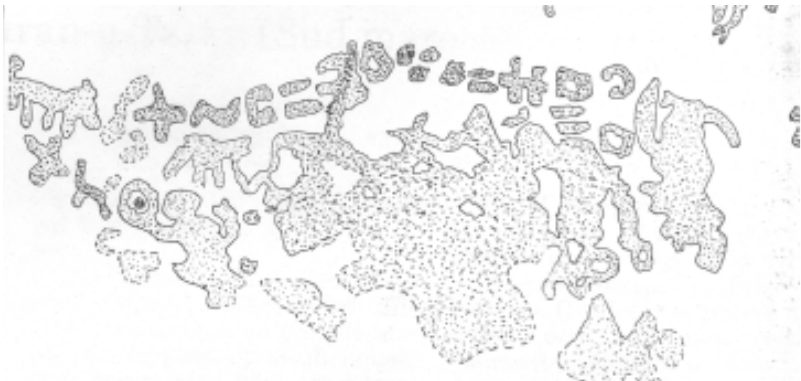
Figure 8. Ifrane-n-Taska: Libyco-Berber letters (from Skounti & Nami,